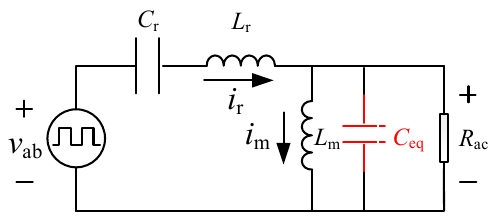
Figure 3. Equivalent circuit of an LLC resonant converter.